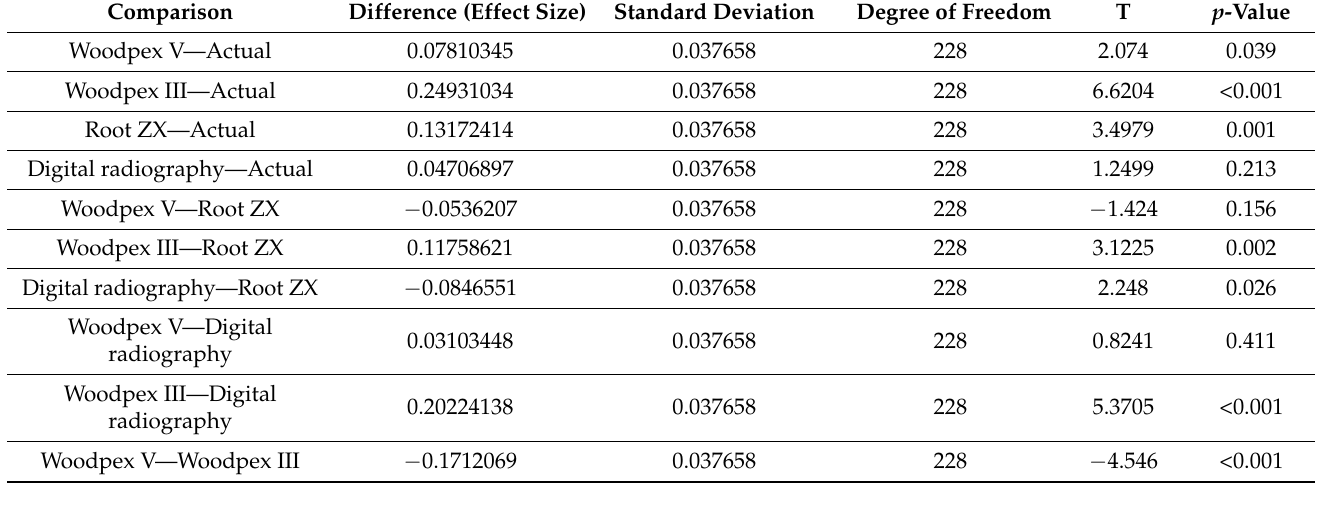
Table 2. Pairwise comparisons of the accuracy of five modalities regarding working length measurement.